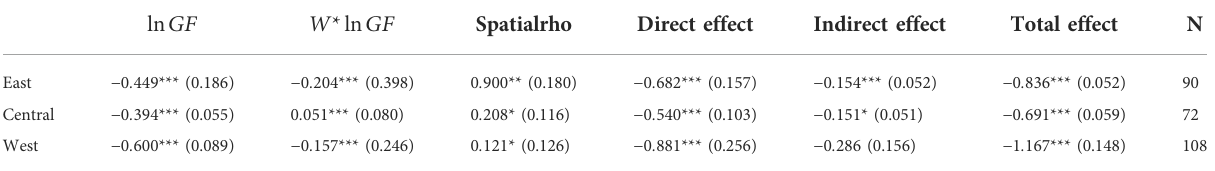
TABLE 7 Subregional empirical